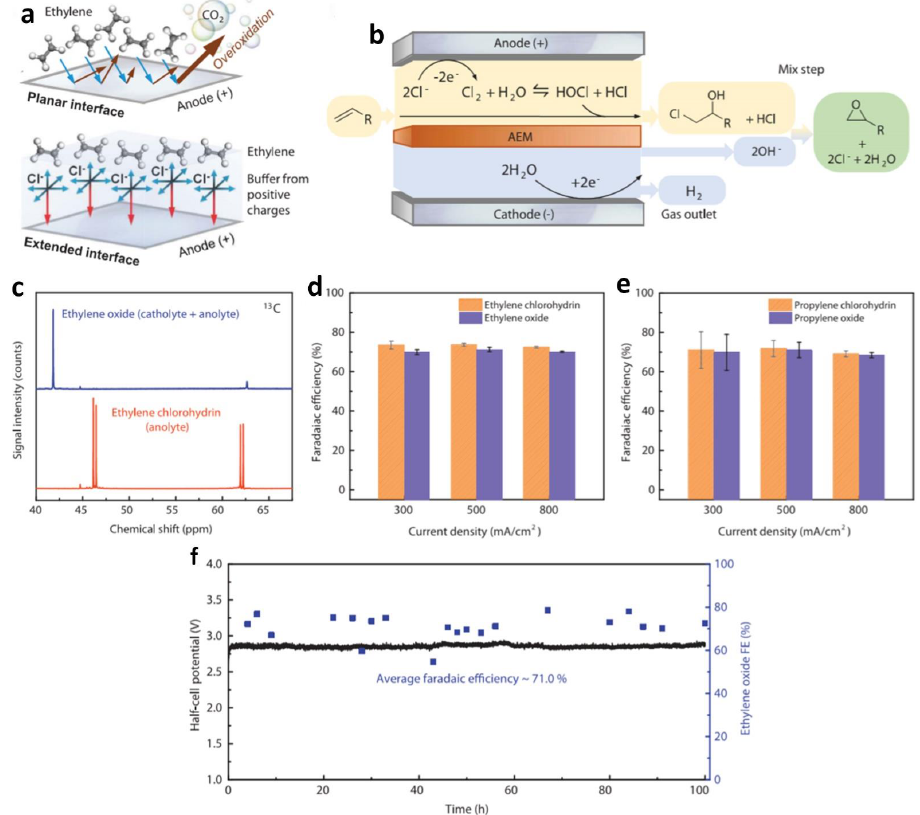
Figure 6. ( a ) Schematic illustration of ethylene electro−oxidation at planar interfaces. ( b ) Schematic illustration of the electrochemical system of ethylene−to–ethylene oxide. ( c ) 13 C NMR spectra of ethylene oxide and ethylene chlorohydrin. ( d ) FE at various current densities. ( e ) FE of propylene chlorohydrin and propylene oxide at various current densities. ( f ) Half-cell potential and FE of ethylene oxide at 300 mA/cm 2 (the squares refer to the FE data obtained at different time). Reproduced with permission [95], Copyright 2021, American Association for the Advancement of Science Publishing Group.